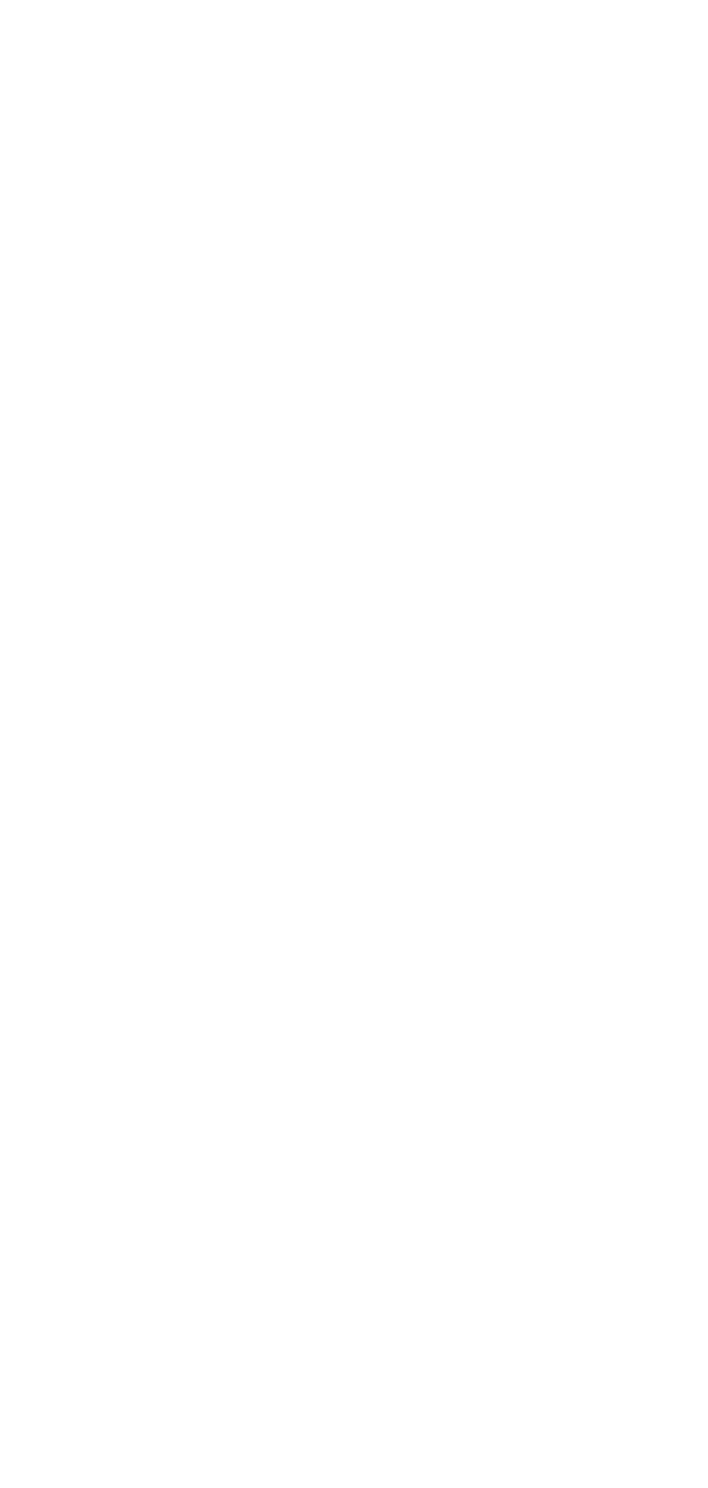
The TGF-β pathway and other intracellular signaling pathways in LM3 cells. (A) Immunoblot analysis of phosphorylated Smad2, p38MAPK and ERK1/2, as well as the levels of total Smad2 and Smad4 in LM3 cells. Actin was used as loading control. (B) Smad4 nuclear localization by immunofluorescence in LM3 cells treated with or without 2 ng/ml TGF-β1 (magnification, ×1000). Mv1Lu cells were used as a control of the TGF-β response. White arrows show Smad4 nuclear localization. (C) Smad-dependent transcriptional activity in LM3 cells in response to 1 ng/ml TGF-β1 for 16 h. Prior to treatment, cells were co-transfected with luciferase reporters SBE-Lux and 3TP-lux (see Materials and methods). NMuMG cells were employed as a control (inset). Experiments were performed in triplicates and repeated at least twice. Data represent the mean ± SD of luciferase relative units (LRU) from triplicates. (D) PAI-1 mRNA expression in LM3 cells treated with or without 2 ng/ml TGF-β1 for 8 or 24 h, by RT-PCR. NMuMG cells were used as control of TGF-β response. β-actin (Actb) was employed as a control.